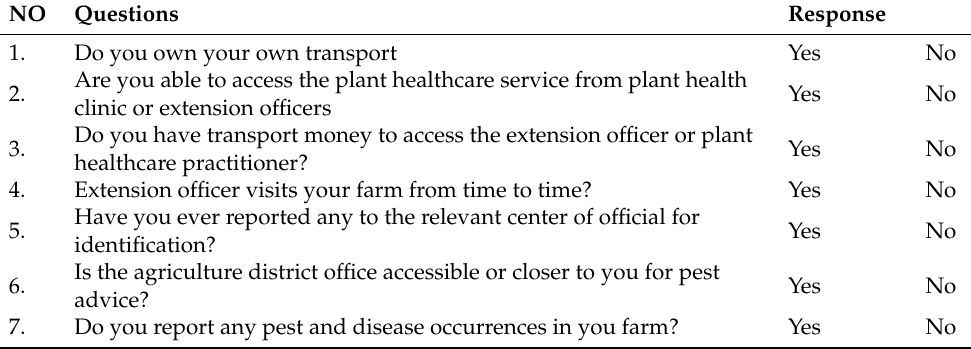
Table A3. Accessibility to plant health clinics.